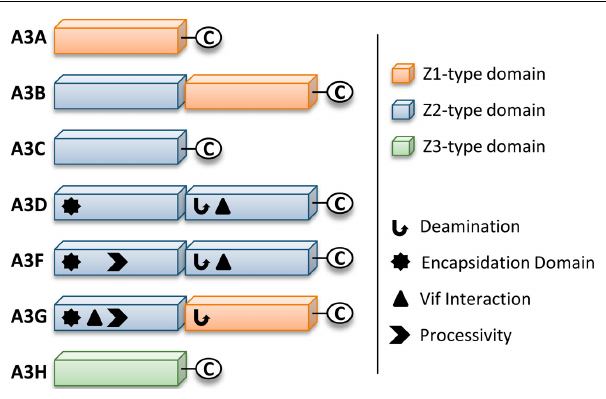
FIGURE 1 | Zinc (Z) coordinating-type domains of humanA3 enzymes. A3 enzymes coordinate zinc through the motif H-X-E-X 23 − 28 -P-C-X 2 − 4 -C. The glutamate activates a water molecule to enable zinc-hydroxide- mediated nucleophilic attack to complete the deamination reaction. Deamination activity has been demonstrated for all A3 enzymes. For the enzymes with two Z-type domains that restrict HIV in CD4 + T cells (A3D, A3F, and A3G), a legend depicts known biochemical functions of each Z-type domain. A common feature of A3 enzymes with two Z-type domains is the segregation of functions in the N-terminal domain (NTD) and C-terminal domain (CTD).The NTD is responsible for encapsidation and the CTD is responsible for deamination activity. Both domains can bind nucleic acids.The binding site ofVif is in the NTD for A3G and in the CTD for A3D and A3F.The determinants for enzyme processivity have only been studied for A3G and A3F. A3G and A3F processivity is imparted by the